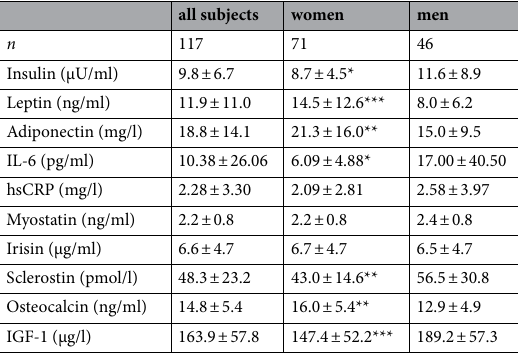
IL-6 levels were negatively associated with bone parameters in men (BMC r = –0.34, BMD r = −0.34, T-Score r = −0.32, all p < 0.05, data are not adjusted for weight). Correlations remained significant after excluding two subjects with elevated IL-6 levels of 146 and 243 pg/ml. No relationship was observed between hsCRP or leptin and bone parameters. To test if an effect of hsCRP or leptin on bone could be masked by weight, partial correla- tion analyses adjusted for weight between hsCRP or leptin and bone parameters were performed and a significant